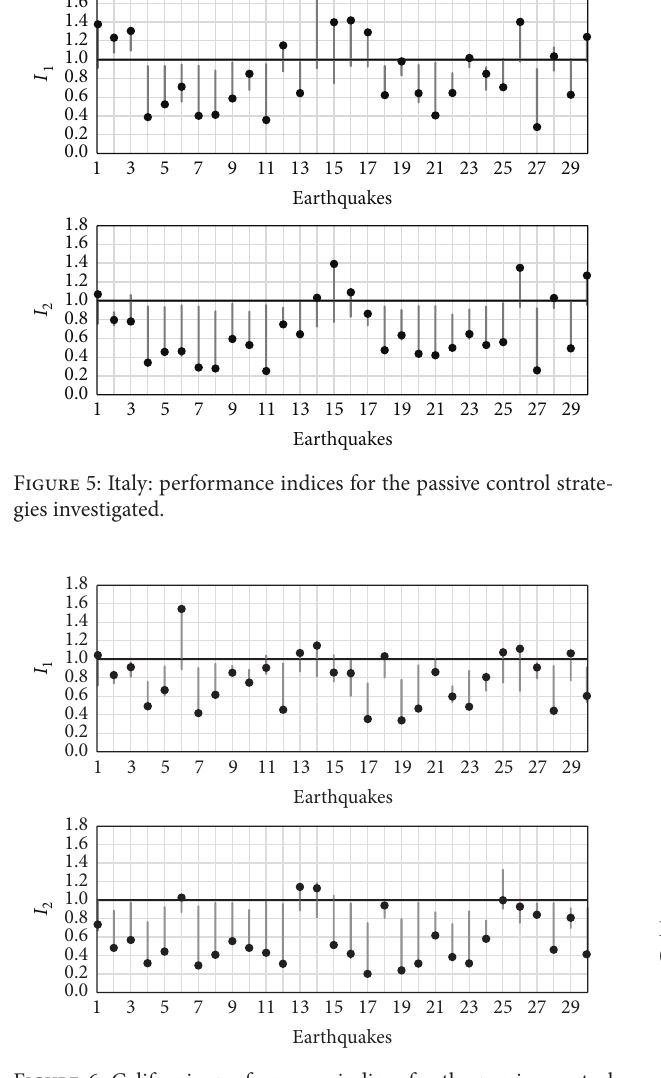
Figure 6: California: performance indices for the passive control strategies investigated.